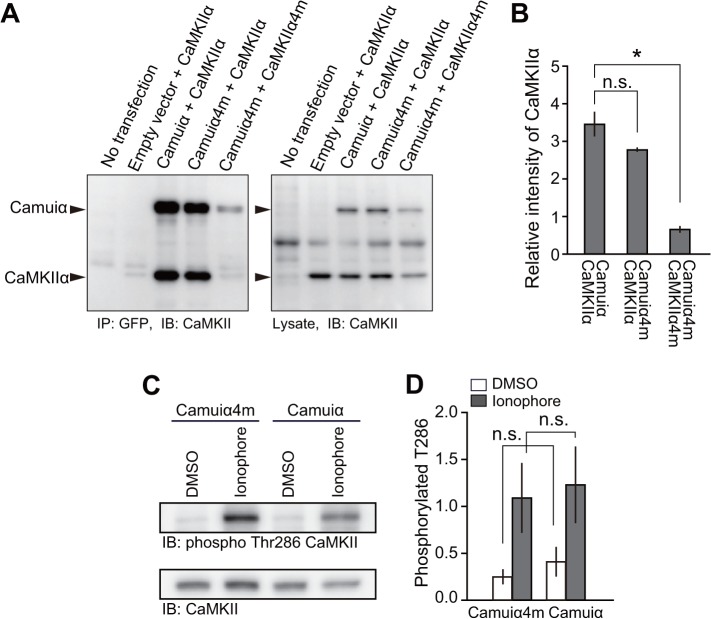
Immunoprecipitation and kinase activity analyses.
(A) HeLa cells expressing Camuiα-mGsR or Camuiα4m-mGsR with non-labeled CaMKIIα or CaMKIIα4m (DNA ratio of 1:2) were lysed and immunoprecipitated with anti-GFP antibody followed by immunoblotting with CaMKII antibody. (B) Quantitative analysis of immunoprecipitation. The band intensities of immunoprecipitated Camuiα and its mutant were divided by those of the lysates. Error bars indicate S.E.M. for three independent experiments. For the statistical test, one-way ANOVA with Scheffé’s post-hoc test with *p < 0.05 was used. (C) HeLa cells expressing Camuiα mutants and calmodulin (DNA ratio of 1:1) were stimulated with 20 μM of 4-bromo-A23187 ionophore for 1 or 2 minutes. Subsequently, the cells were lysed and immunoblotted with anti-phosphoThr286 CaMKII antibody. As a control experiment, DMSO was added instead of ionophore. (D) Quantitative analysis of Camuiα mutant activation. The band intensities of phosphorylated Camuiα mutant were divided by those of the lysates. Error bars indicate S.E.M. for three independent experiments. There were no significant differences between the phosphorylation levels of Camuiα and Camuiα4m (p > 0.05, t-test, n.s., not significant).